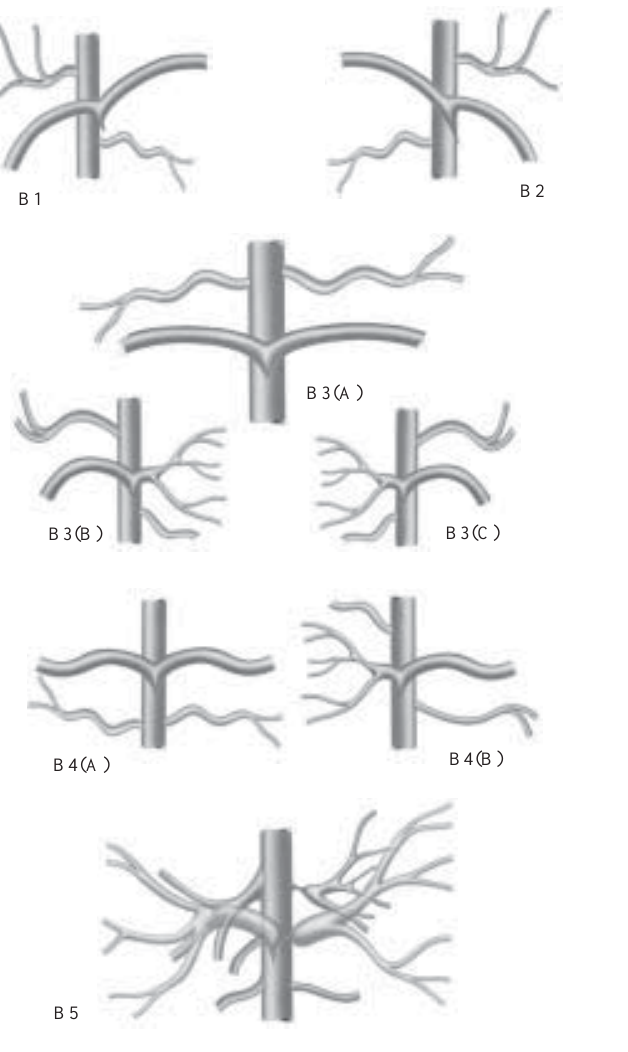
Fig 3. Schematic representation of the B1 subgroup with central pulmonary arteries supplying the left superior and right inferior lobes. The other lobes were irrigated by major aortopulmonary collateral arteries. The subgroup B2 with central pulmonary arteries supplying the upper right and left lower lobes. All the other lobes were irrigated by the major aortopulmonary collateral arteries. In subgroup B3 with central pulmonary arteries supplying the left and right lower lobes (A) or central pulmonary arteries supplying all the lobes of the left lung and the right upper lobe (B). central pulmonary arteries supplying all the lobes of the right lung and the left upper lobe (C). The other lobes being supplied by major aortopulmonary collateral arteries (A, B and C). In subgroup B4 with central pulmonary arteries supplying the left and right upper lobes (A). central pulmonary arteries supplying all the lobes of the left lung and the upper lobe of the right lung (B). The other lobes being supplied by major aortopulmonary collateral arteries (A and B). In subgroup B5 with central pulmonary arteries and major aortopulmonary collateral arteries supplying lobes without possibility of exact definition.